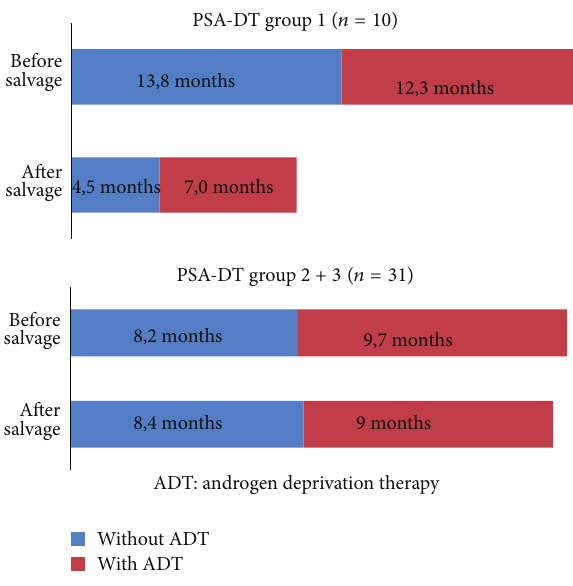
Figure 5: Dynamic of PSA-DT in